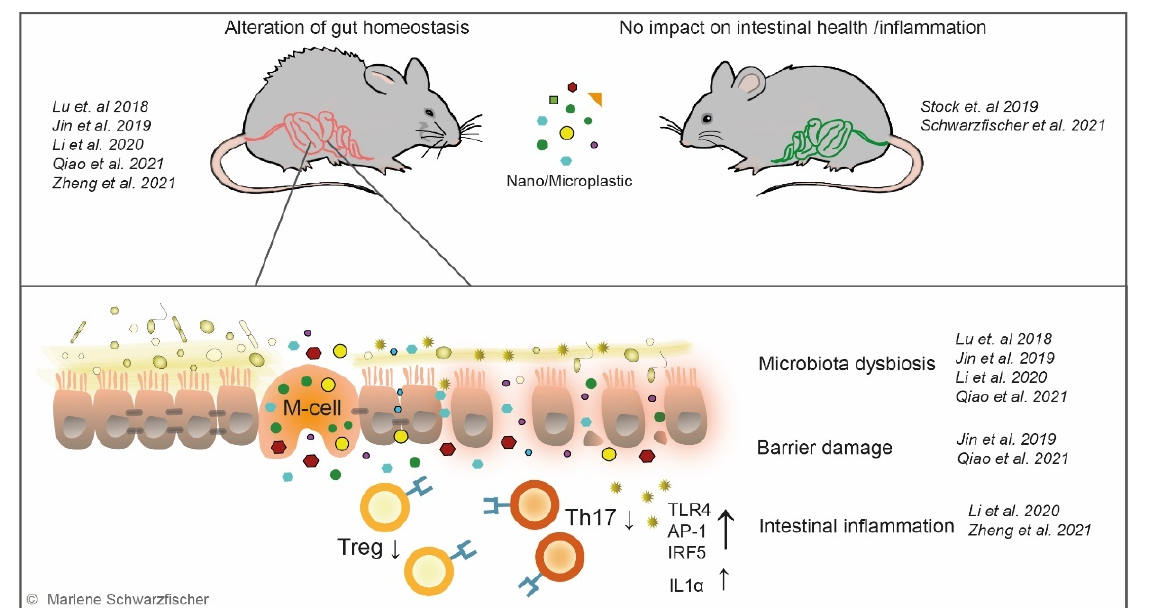
Figure 4. Nano- and microplastics—impact on gut homeostasis. The impact of nano- and micro-sized plastic particles on the intestine is controversially discussed, and the number of studies investigating these relations is limited. It is assumed that small plastic particles take the same routes as TiO 2 nanoparticles and penetrate the intestinal epithelium. Although two publications did not detect any effects of NP or MP on intestinal health and/or inflammation, respectively, conflicting studies report alteration of the gut homeostasis upon plastic administration in mouse models. Several studies describe adverse effects on the gut microbiome, reduced mucus secretion, and damage of barrier integrity upon administration of MP particles. Li et al. describe the reduction in regulatory T-cells (Treg) and Th17 cells, increased Toll-like receptor 4 (TLR4) downstream signaling, and IL1 α